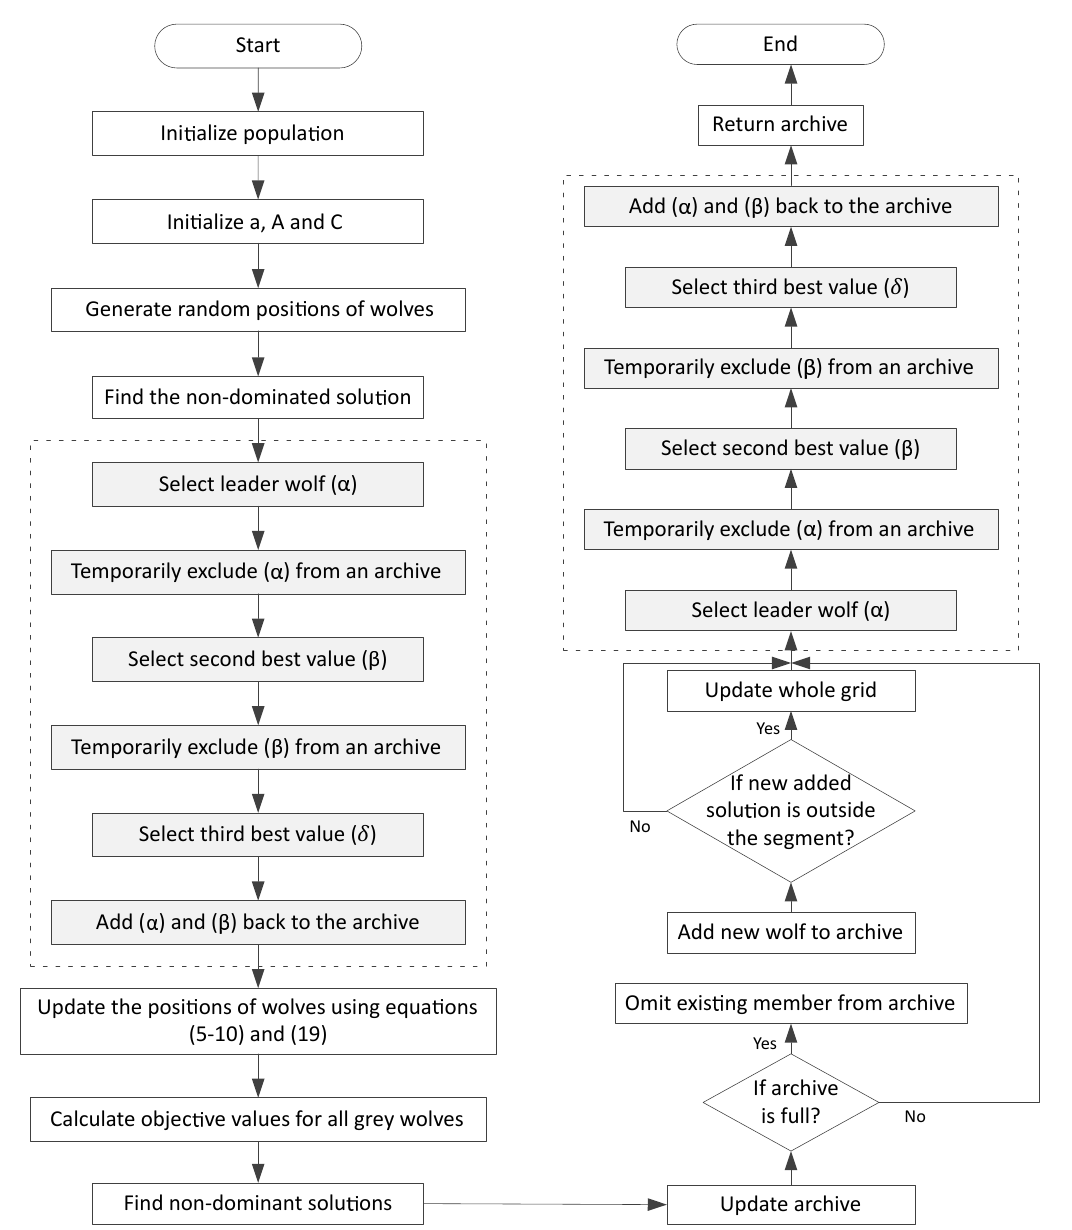
Figure 5. Flowchart of